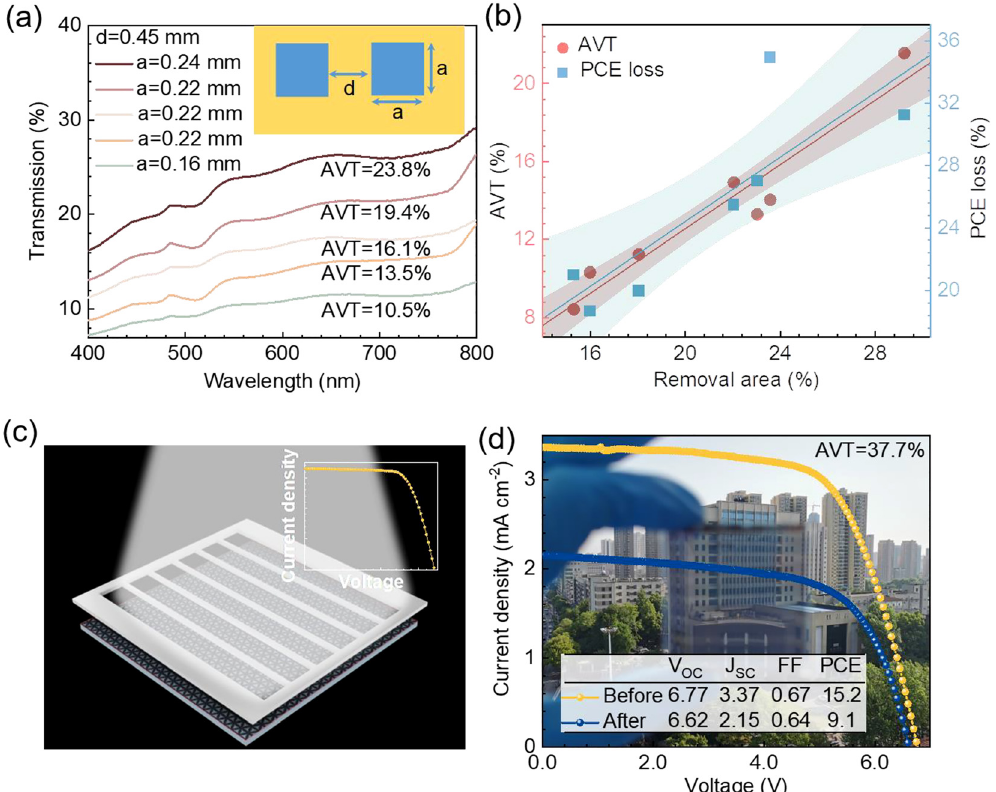
Figure 4: Photovoltaic performance characterizations of ST-PSCs. (a)ThetransmissioncurveofST-PSCsiscausedbyincreasingthesidelengthoftheremovedsquare.(b)TransmissionandPCElossarelinearly fitted as a function of the removal area. (c) Schematic diagram of mask-assisted PCE test. (d) Comparison of the current − voltage characteristics of 5 × 5 cm 2 PSCs before and after laser